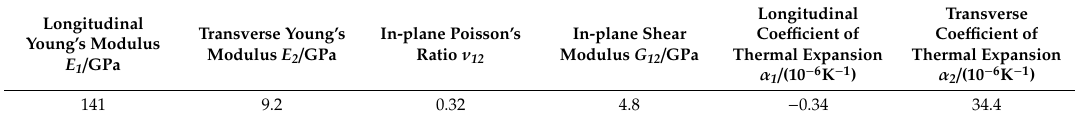
Table 1. Homogenized ply properties for AS4 / 8552